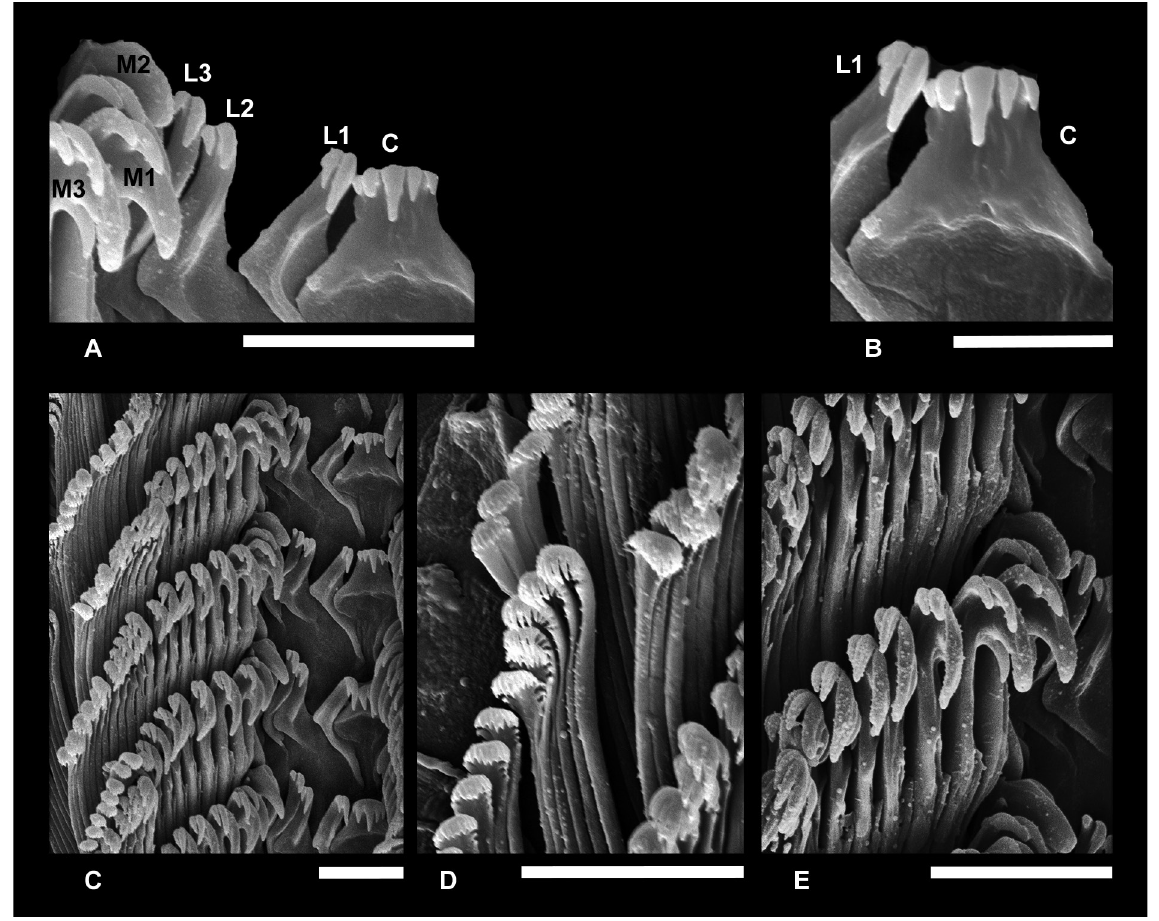
Fig. 10. SEM images of radula of Anatoma laevapex sp. nov., I19_033RO (I19_Ma_97). A . Central, lateral and inner marginal teeth. B . Central and inner lateral teeth. C . SEM image of half radula with central, lateral, inner and outer marginal teeth. D . Outer marginal teeth. E . Inner marginal teeth. Abbreviations: C = central (rachidian) tooth; L1, L2, L3 = inner lateral teeth; M1, M2, M3 = inner marginal teeth. Scale bars: A, C–E = 10 μm; B = 5